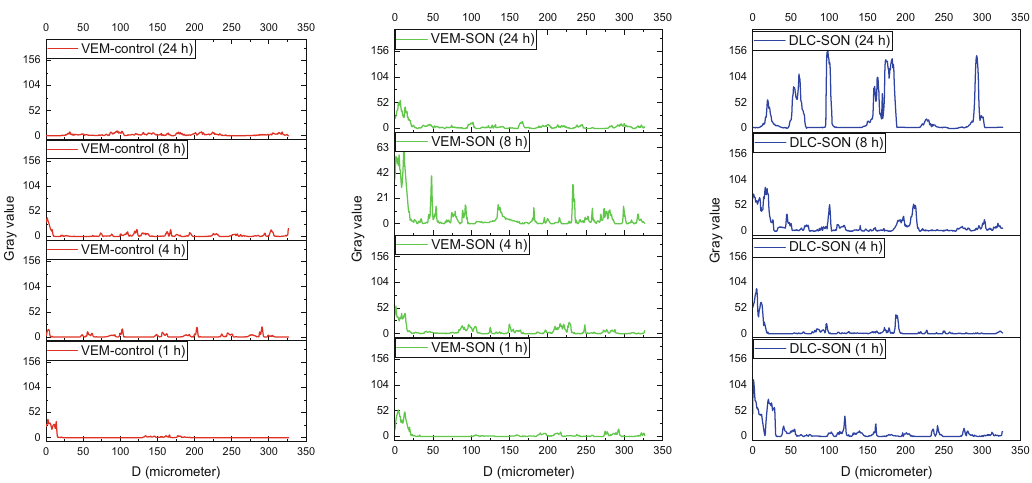
Figure 12. The luminescence or gray value versus skin diameter (in μ m) for the treated rats' skin sections treated with VEM-control, the prepared VEM-SON, and DLC-SON, after application of LYCH and FITC in the CSLM images were quantified using the software